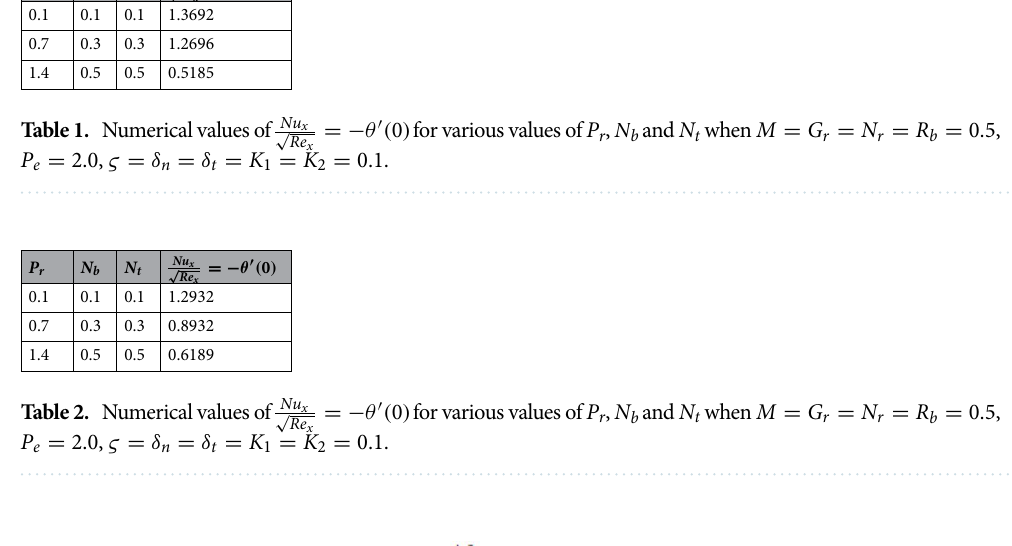
Table 2. Numerical values of P